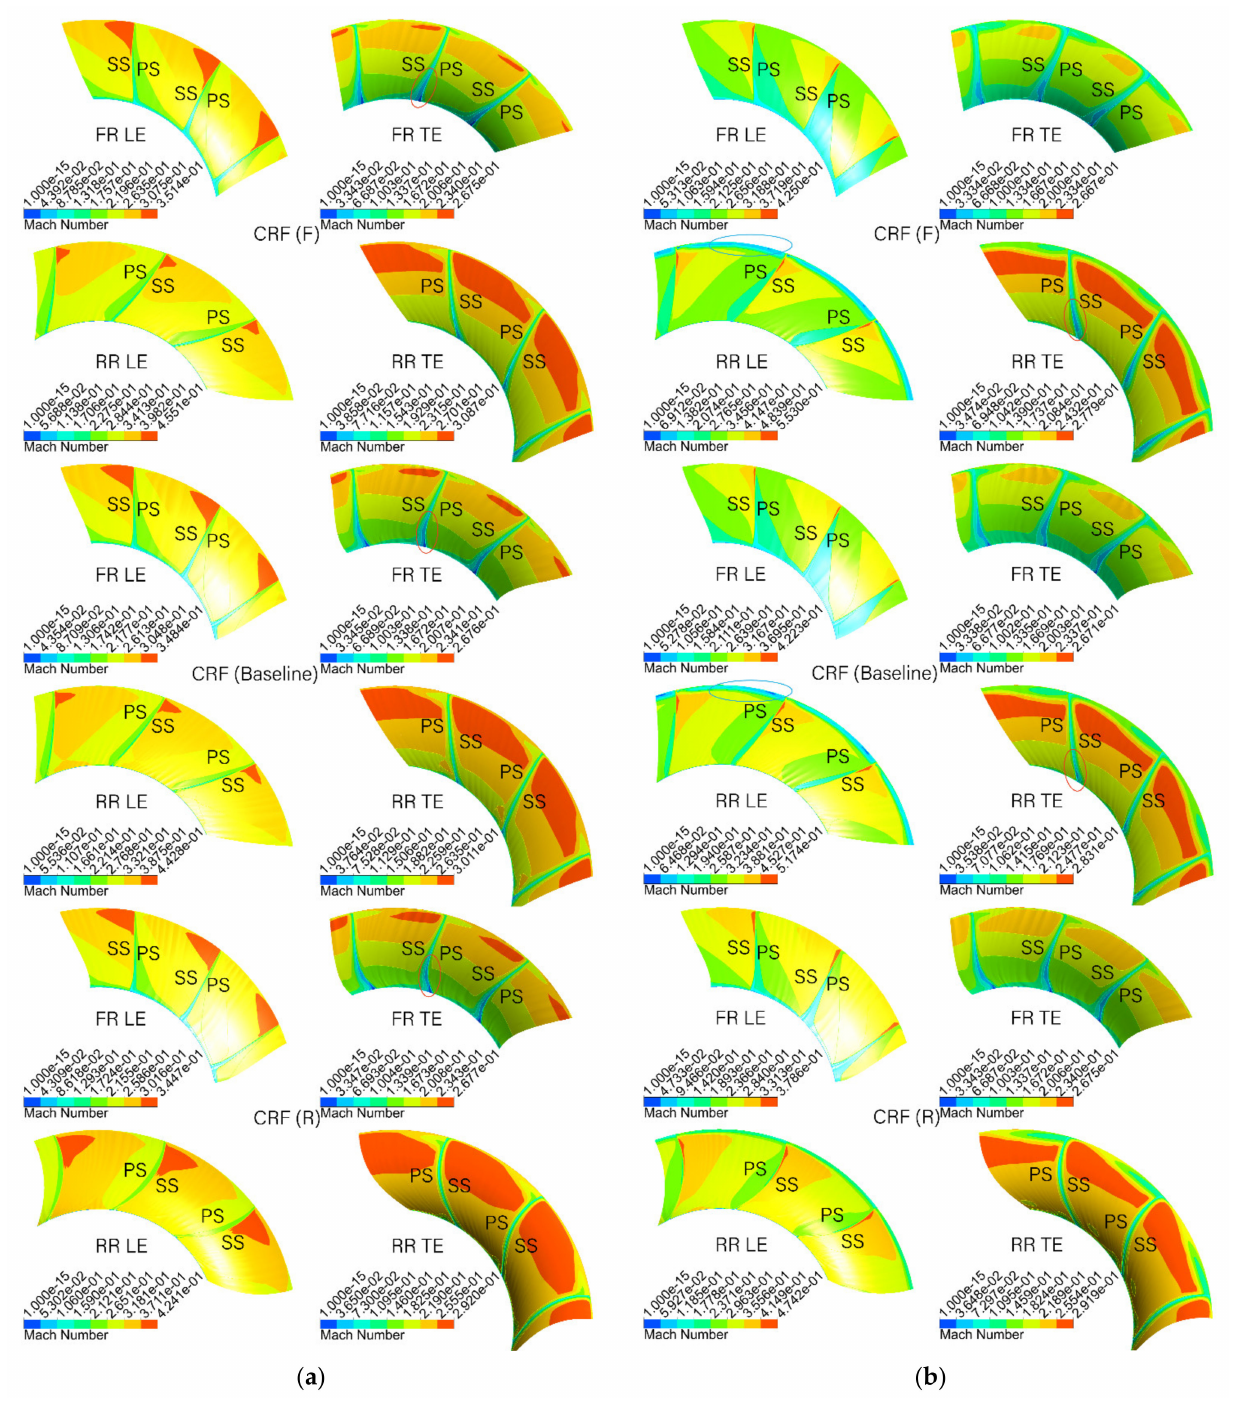
Figure 16. ( a ) Comparison of three sets of CRFs based on the Mach number contour at the design points; ( b ) comparison of three sets of CRFs based on the Mach number contour near the stall